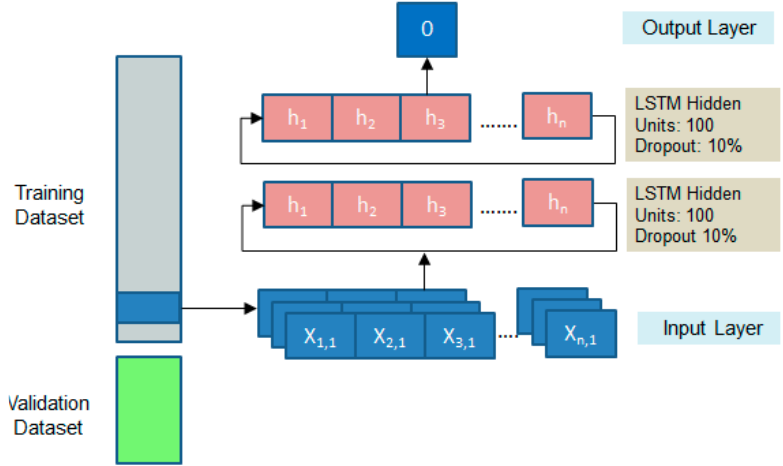
Figure 22. Graphical representation of the LSTM and its hyperparameters.